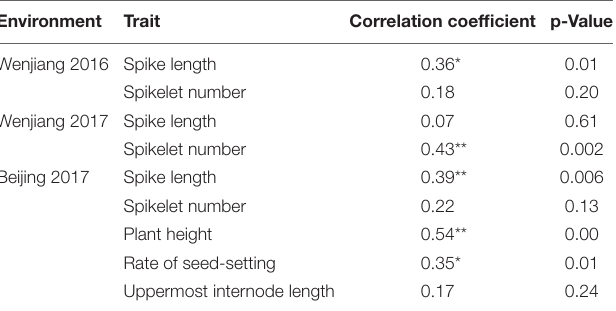
TABLE 3 | Correlations between aneuploid frequency and standard deviations in RILs. Environment Trait Correlation coefficient